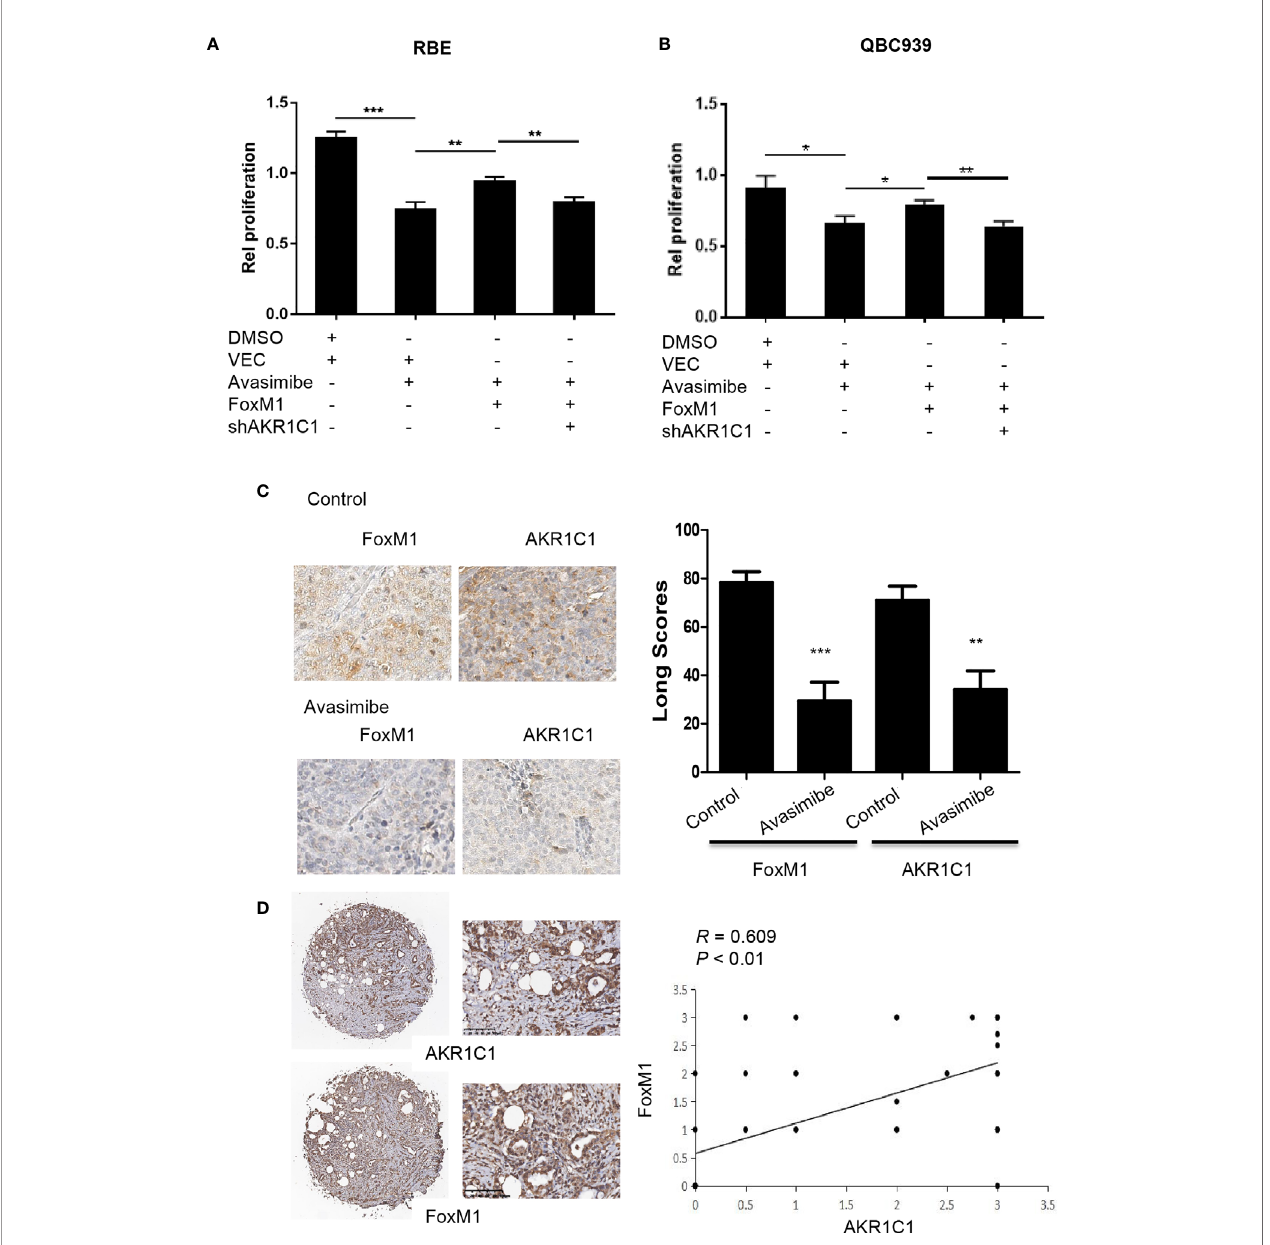
FIGURE 6 | Avasimibe inhibits cholangiocarcinoma cells proliferation via targeting AKR1C1 and FoxM1. (A, B) RBE cells (A) and QBC939 cells (B) were treated with avasimibe or DMSO, then transfected with FoxM1 or control vector, along with the transfection with AKR1C1 shRNA or shNT. 48 h after transfection, cell viability was analyzed by CCK8 assay. Data are from three independent assays. *P < 0.05, **P < 0.01, ***P < 0.001. (C) Left panel, the expression of FoxM1 and AKR1C1 was detected by IHC on the resected xenografts. IHC, ×400. Right panel, diagram showing the different expression of FoxM1 and AKR1C1 in these samples when treated with avasimibe. (D) The representative images of FoxM1 and AKR1C1 expressions and their correlations determined by Spearman ’ s correlation test. r, Spearman correlation coef fi cient; IHC, ×40 or